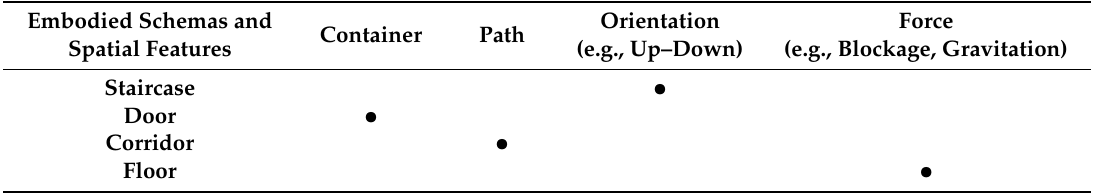
Table 1. Matrix of embodied schemas and spatial features.